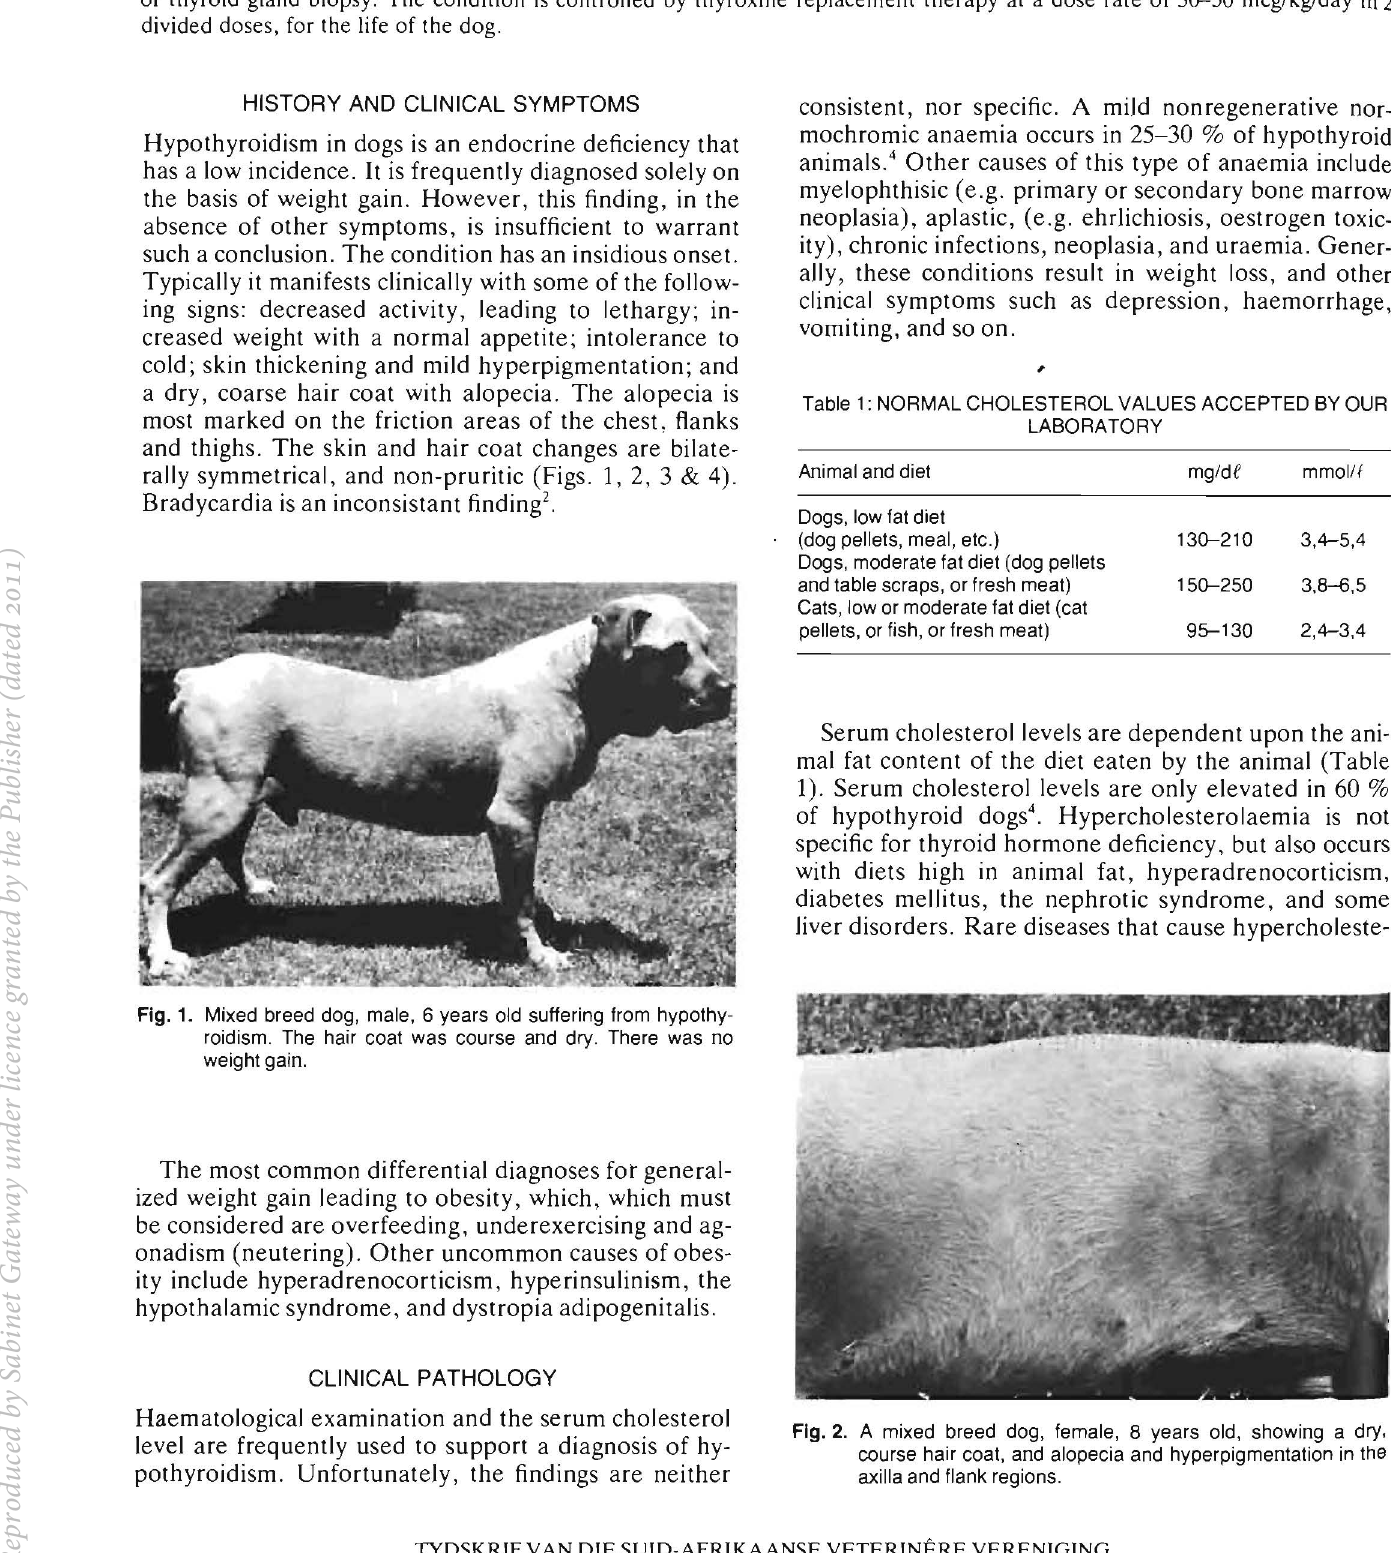
Fig. 2. A mixed breed dog, female, 8 years old, showing a dry, course hair coat, and alopecia and hyperpigmentation in the axilla and flank